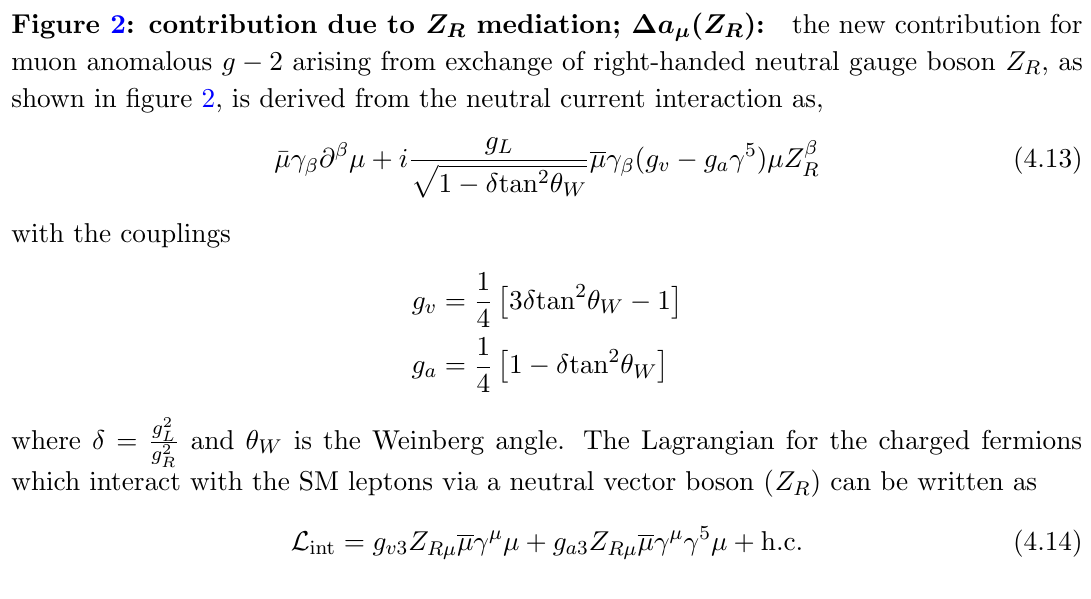
Figure 2: contribution due to Z